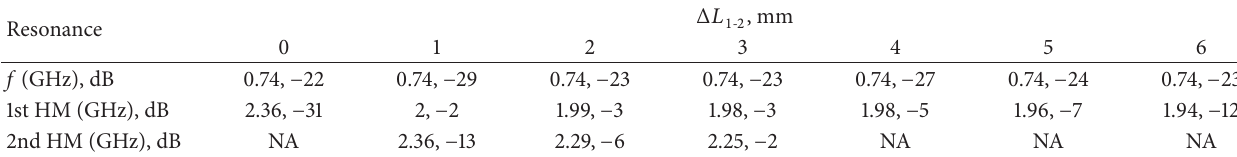
Table 5: Effect of stubfilter’s length on resonance in Figure 1 is location of stub 2 with respect to stub